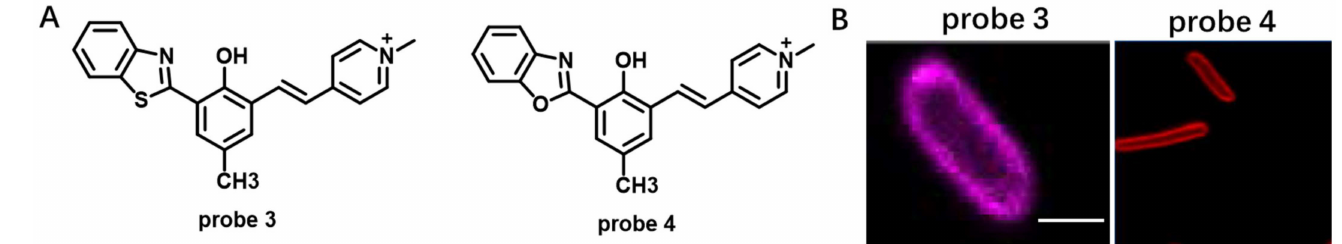
Figure 3. ( A ) Chemical structures of probe 3 and probe 4 . ( B ) Confocal images of prokaryotic cells using probe 3 and probe 4 . Scale bar: 2 µ m. Copyright 2018 Elsevier [54] and Copyright 2018 Elsevier [55].